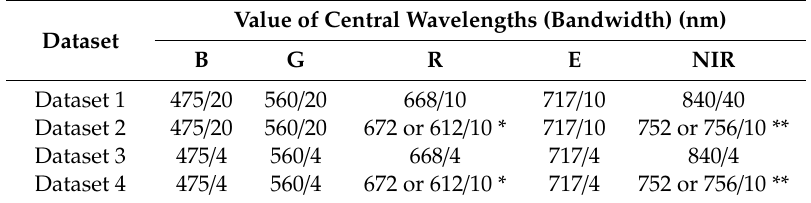
Table 8. Four UAV datasets used for LAI